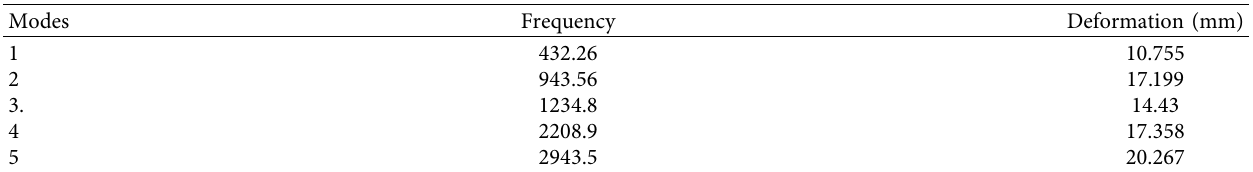
Table 9: Modal analysis results of FGM